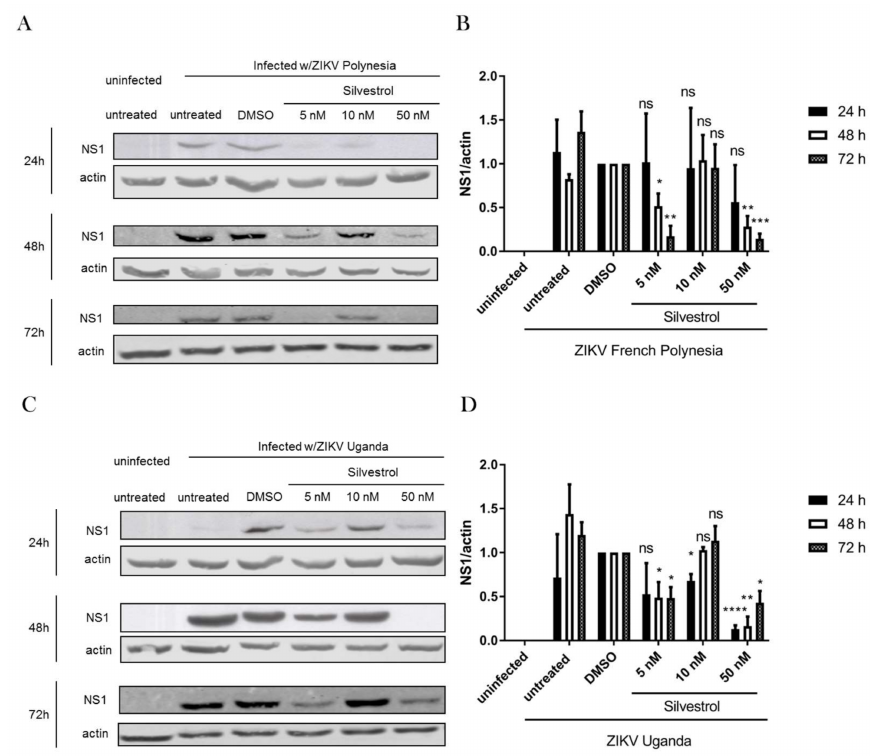
Figure 4. Silvestrol treatment reduces the amount of intracellular NS1 protein. ( A ) A549 cells were infected with ZIKV U and treated with the indicated amount of silvestrol. Cell lysates of the indicated time points were analyzed by Western blot with specific antibodies against NS1 and β -actin; ( B ) Quantification of densitometry scans examples are shown in ( A ); ( C ) A549 cells were infected with ZIKV FP and treated with the indicated amount of silvestrol. Cell lysates of the indicated time points were analyzed by Western blot with specific antibodies against NS1 and β -actin; ( D ) Quantification of densitometry scans examples are shown in ( C ). ns = not significant = p > 0.05; * = p ≤ 0.05; ** = p ≤ 0.01; *** = p ≤ 0.001; **** = p ≤